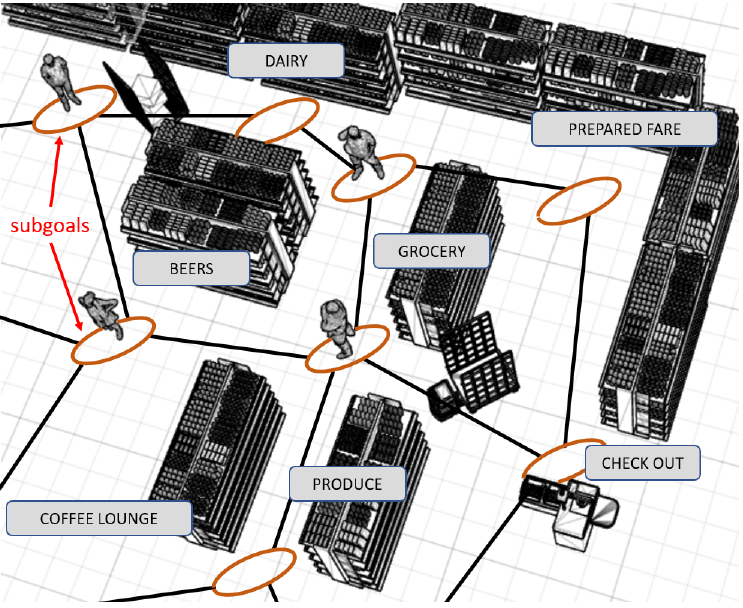
Figure 8. Examples of a distribution of sub-goals in an environment